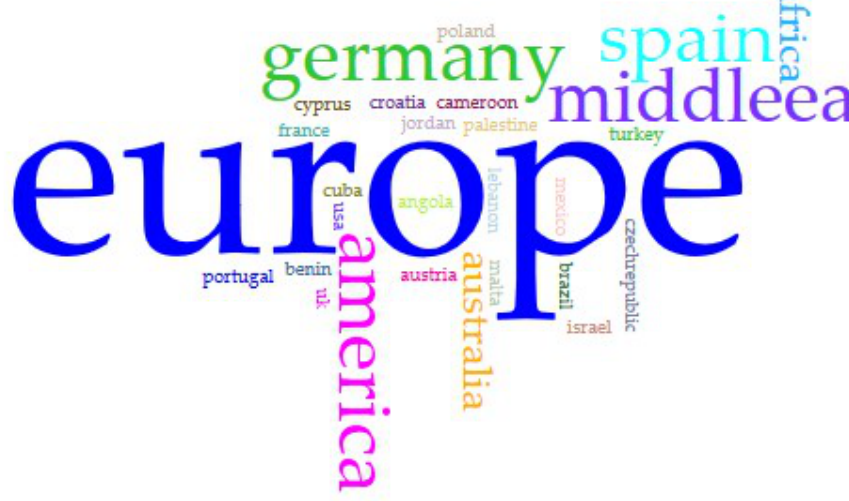
Figure 1. Global Journeys by Benedict XVI (own figure, copyright by the author).